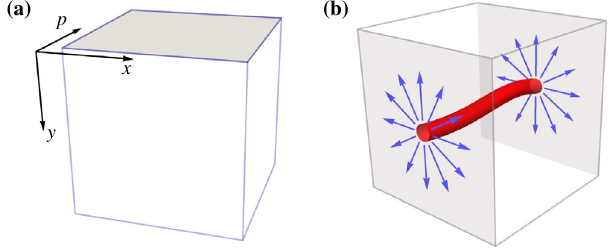
FIG. 1. (a) The D ¼ 3 synthetic TI with d ¼ 2 , and the lattice momentum p is physically a tuning parameter. We always consider the boundary parallel with the synthetic dimensions. Here, the exposed boundary is in the ð x; p Þ plane with a fixed y coordinate. (b) The vortex line of the complex bosonic order parameter ϕ in Eq. (13), and there is one nonchiral 1 d Majorana fermion mode localized in the core of the vortex line [Eq.